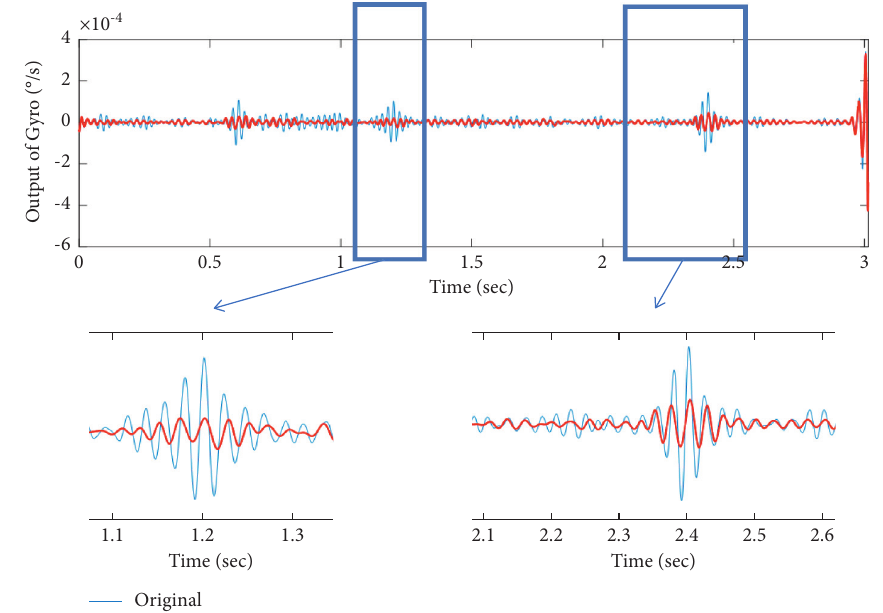
Figure 13: The result of SG filter.